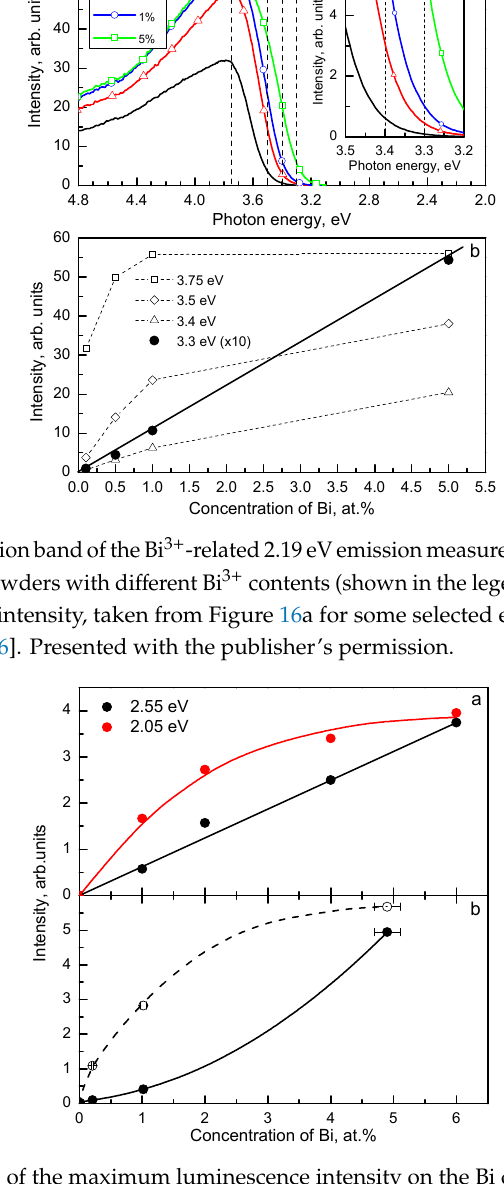
Figure 17. Dependences of the maximum luminescence intensity on the Bi content inside the powder measured at 80 K ( a ) for the 2.55 eV and 2.05 eV emission bands of Gd 3 Ga 5 O 12 :Bi under excitation E exc = 4.08 eV and E exc = 3.4 eV, respectively and ( b ) for the 2.41 eV emission of YNbO 4 :Bi under excitation E exc = 3.6 eV (solid line) and for the 2.53 eV emission of YNbO 4 :Bi under excitation in the absorption band maximum (E exc = 4.09 eV, dashed line). Based on the data reported in [75–77]. Presented with the publisher’s permission.